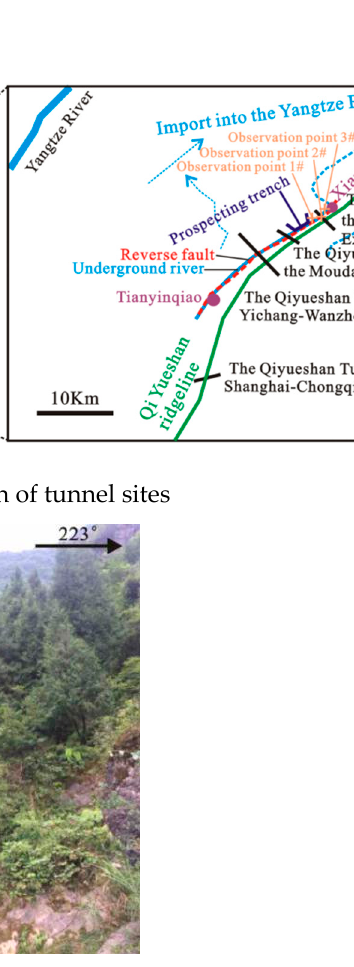
Figure 1. Relative distribution map of the tunnel area.